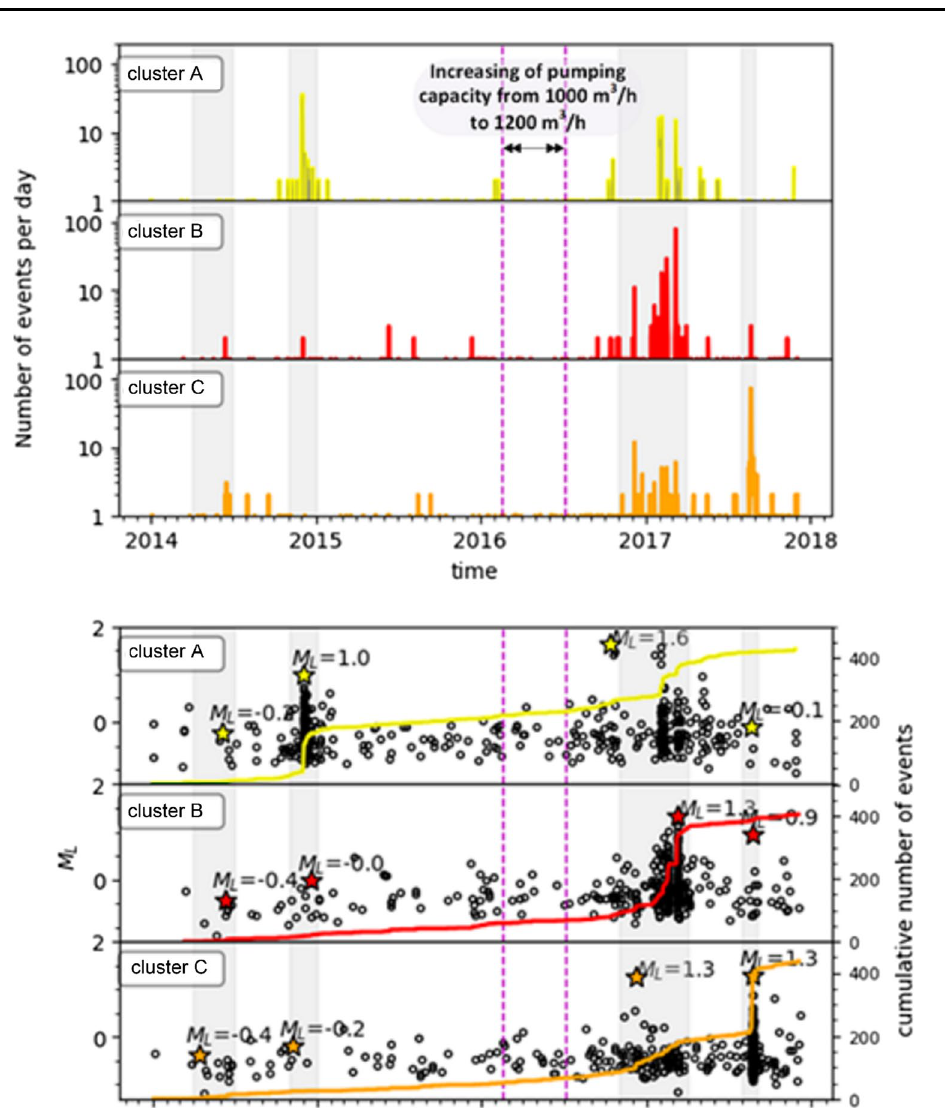
Fig. 3 Temporal distribution of seismic activity for A and B class events, for central and north clusters: a Total seismic activity per day (top), and each cluster separately (figures below), compared